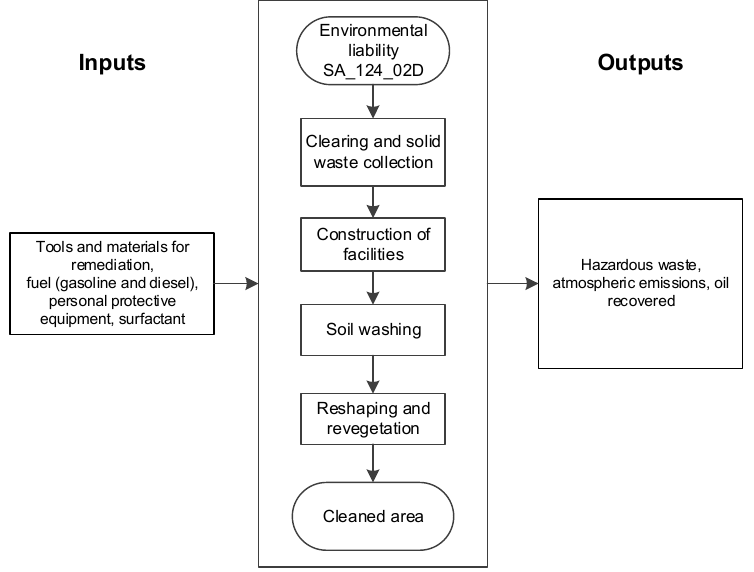
Figure 1. System boundary of remediation activities scenario.